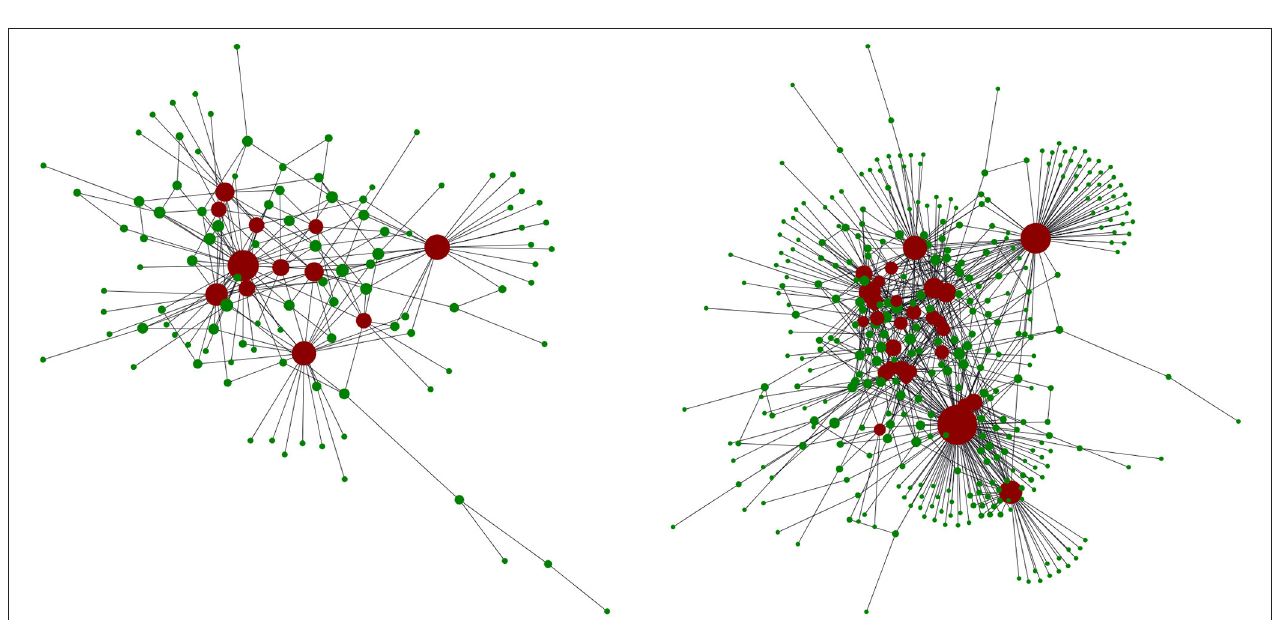
FIGURE 7 | Core-periphery structure of the BLN daily-block representation on day 17 (left panel) and on day 35 (right panel), with core nodes shown in red and periphery nodes in green. Adapted from Lin et al. [ 28].